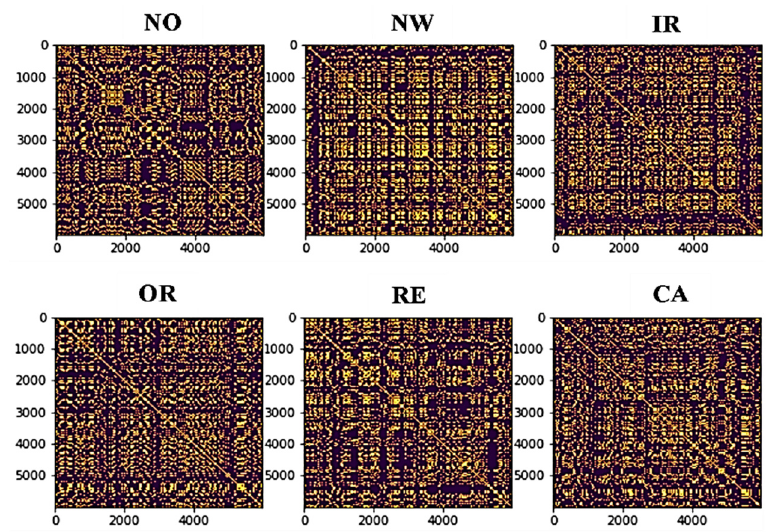
Figure 12. Examples of the generated vibration image using the RP technique with a point threshold for bearing vibration with six health conditions.